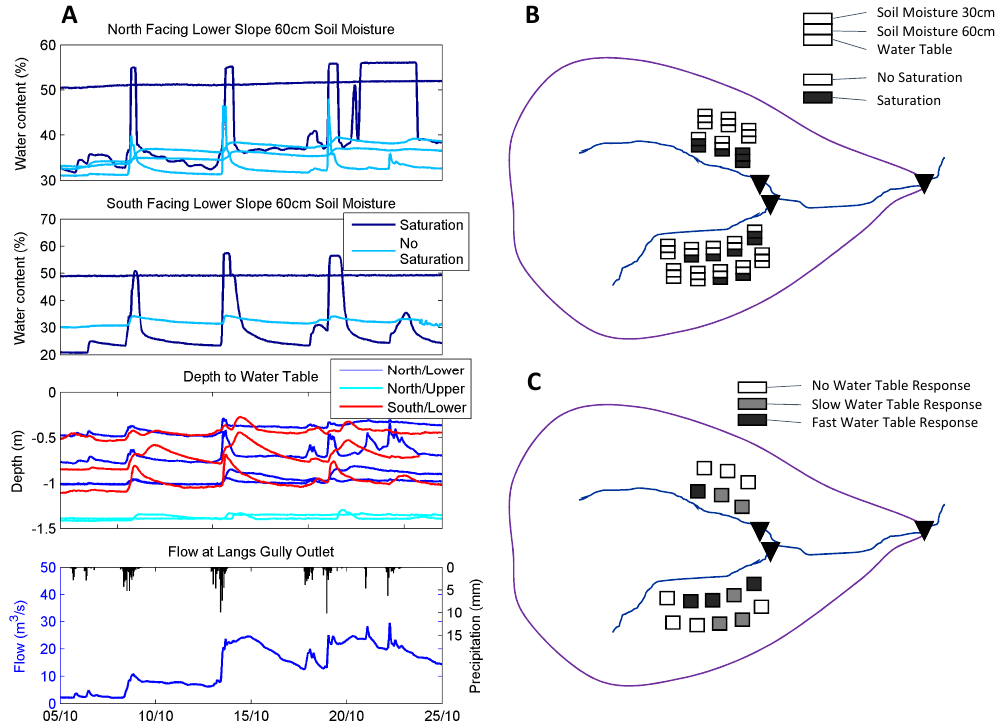
Figure 9. (a) Response of selected sensors to a winter rainfall event. First and second panels: soil moisture responses in north-facing and south-facing slopes respectively. Dark lines show sensors where saturation occurred. Third panel: depth to water table by well location. Fourth panel: storm precipitation and flow measured at the catchment outlet. (b) Overview of saturation response to the winter rainfall event. (c) Overview of rate of water table response to the winter rainfall